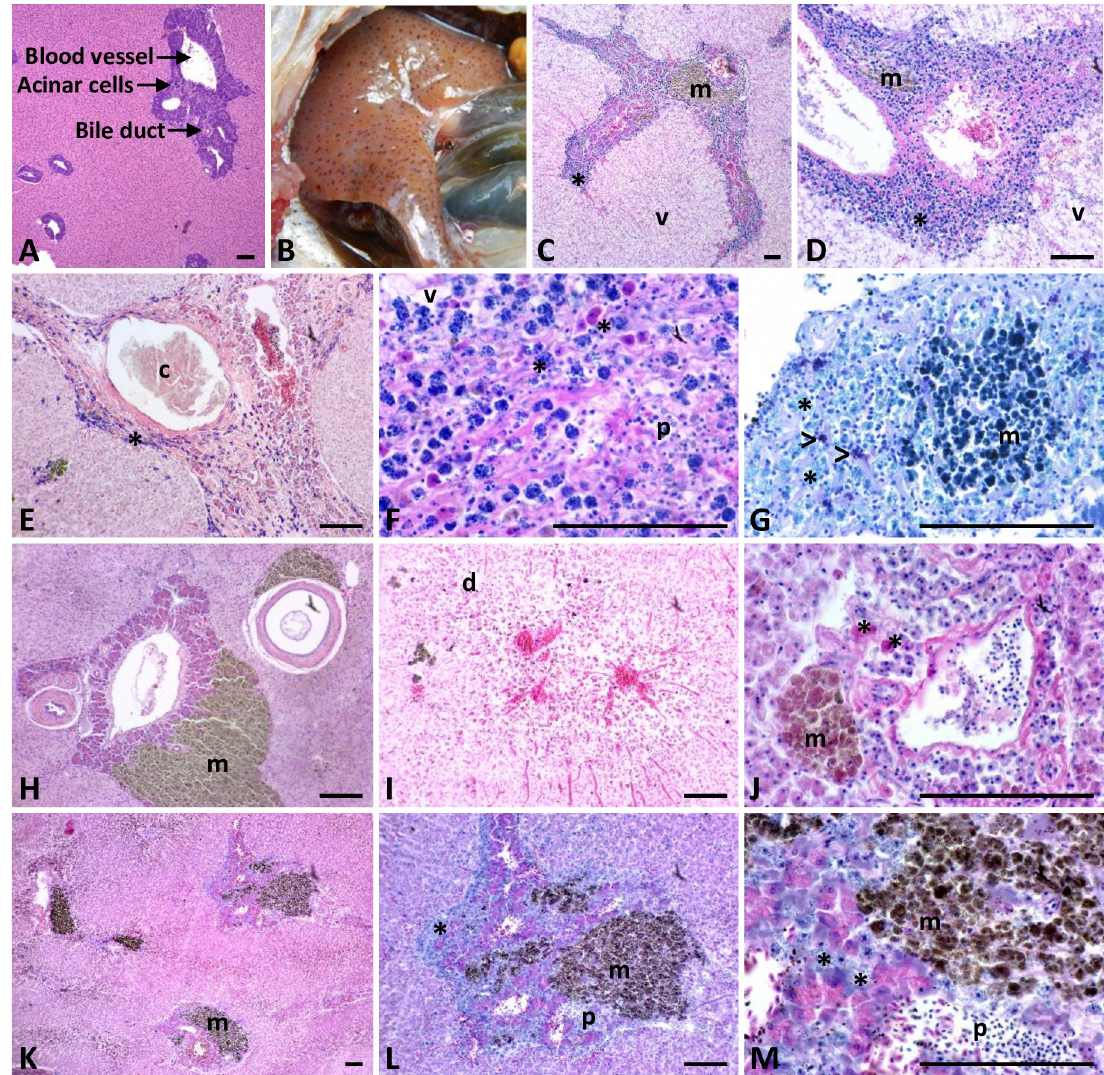
Fig 7. Normal and pathologic hepatic histology. Normal liver histology for Oreochromis mossambicus collected in South Africa (A) followed by representative hepatic inflammatory pathologies observed in three species of Okavango tilapia: Oreochromis andersonii (B-G), Coptodon rendalli (H-J), and Oreochromis macrochir (K-M). Sequentially magnified images of the same histological section are shown in K-M. Macroscopically, melanomacrophage aggregates appear as pigmented dots on the liver (B). Inflammation was characterized by species-specific aggregations of basophilic (C-G, K-M) or eosinophilic (F, J) granulocytes ( � ) that surrounded acinar cell clusters. Some individuals exhibited both basophilic and eosinophilic granulocytes, such as the threespot tilapia shown in (F). Purple mast cells ( > ) were distinguished from other granulocytes ( � ) by staining with toluidine blue (G). Other common pathological features, observed in all three species, included thickened blood vessel and bile duct walls (D, E, H), fibrosis (D, E, F, J), dilated or congested blood vessels and sinusoids (I), large melanomacrophage aggregates (m) (C, D, G, H, J-M), and varying degrees of brown, intracellular ceroid pigment accumulation within hepatocytes (E, H, I, K, L). In more advanced cases, fibrosis worsened and was associated with fluid filled hepatic cysts (c) (E), lymphocytic infiltration (p) (F, L, M), vacuolar degeneration (v) (C, D, F), glycogen depletion (D), and cellular destruction (d) (I) that originated within acinar bundles and then moved out to surrounding hepatocytes, resulting in total loss of acinar clusters (D, E, F, I, J). All scale bars are 100 μ m. Higher resolution images are available in S4